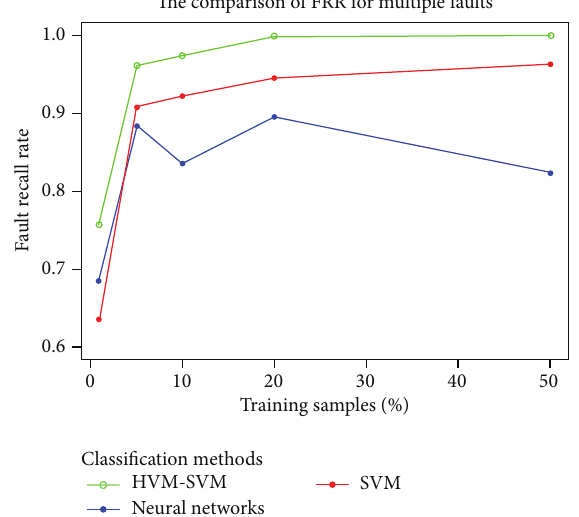
Figure 12: The FRR of three methods to multiple faults diagnosis.